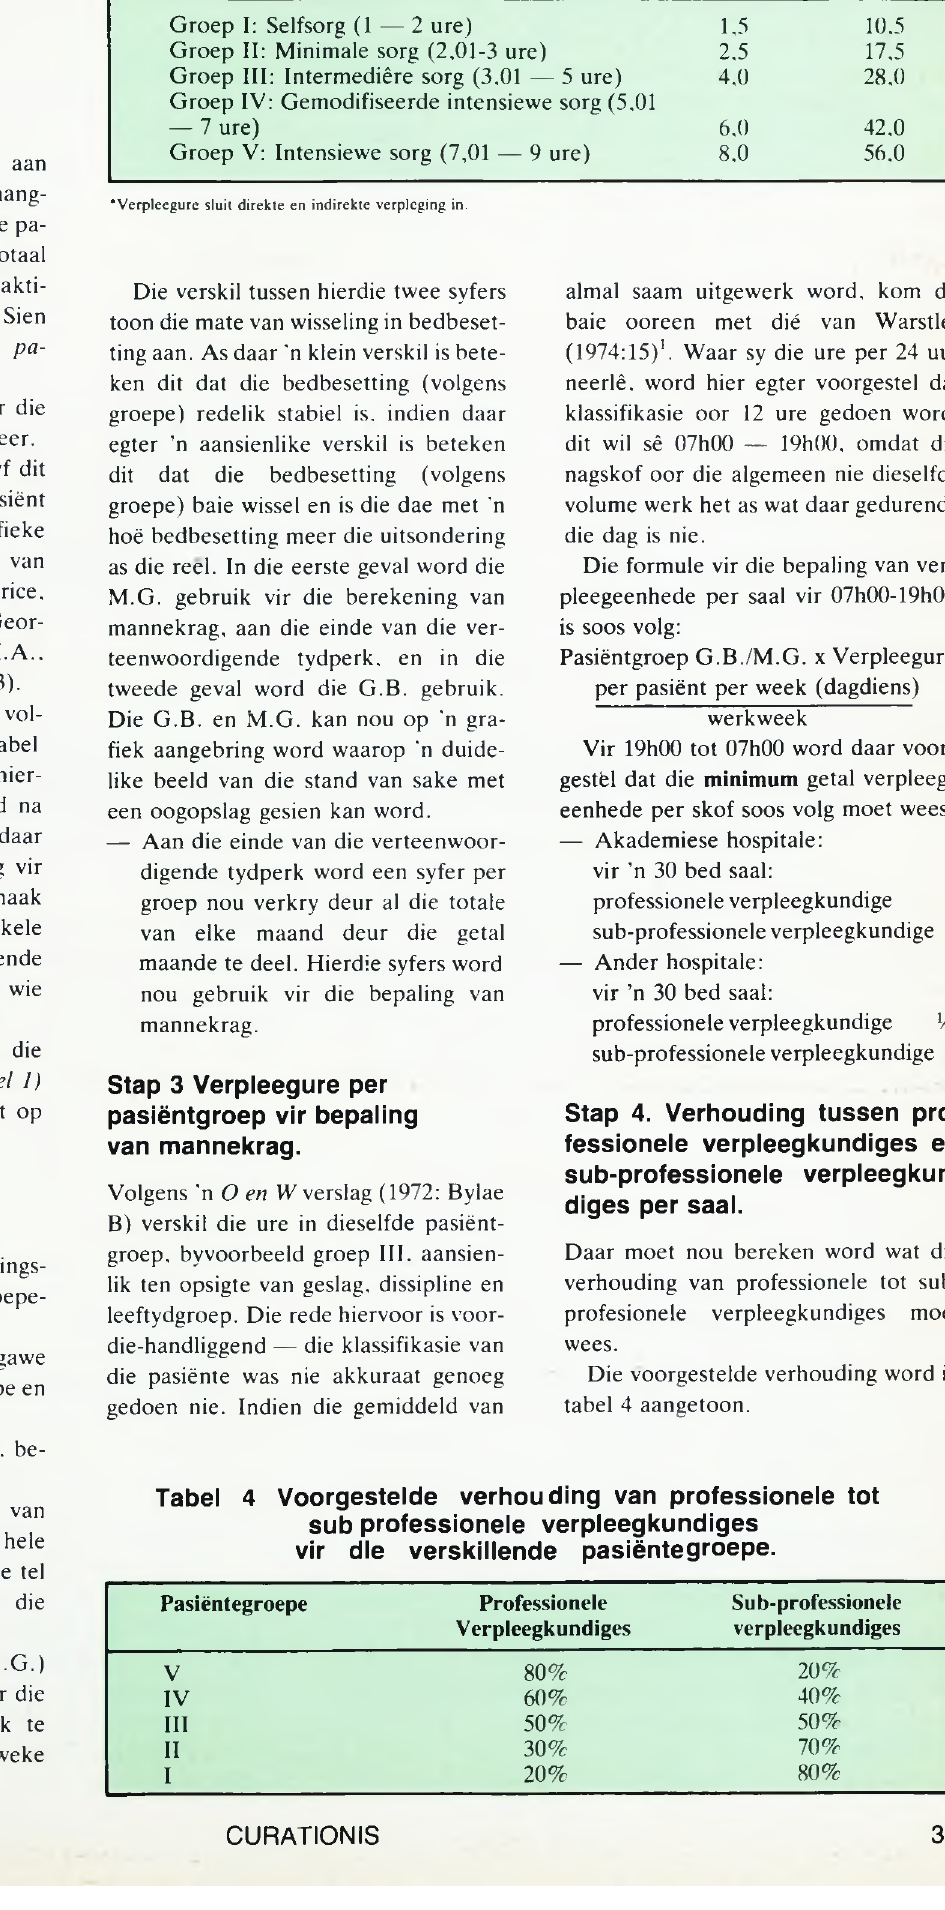
Tabel 3. Voorgestelde* verpieegure per pasiënt vir 07h00 — 19h00 Pasiëntklassifikasie Groep I: Selfsorg (1 — 2 ure)